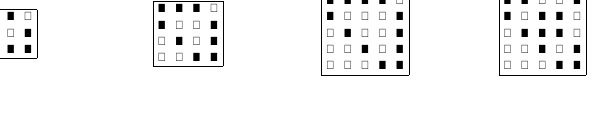
(cid:4) (cid:4) (cid:3) (cid:4) (cid:3) (cid:4) (cid:3)